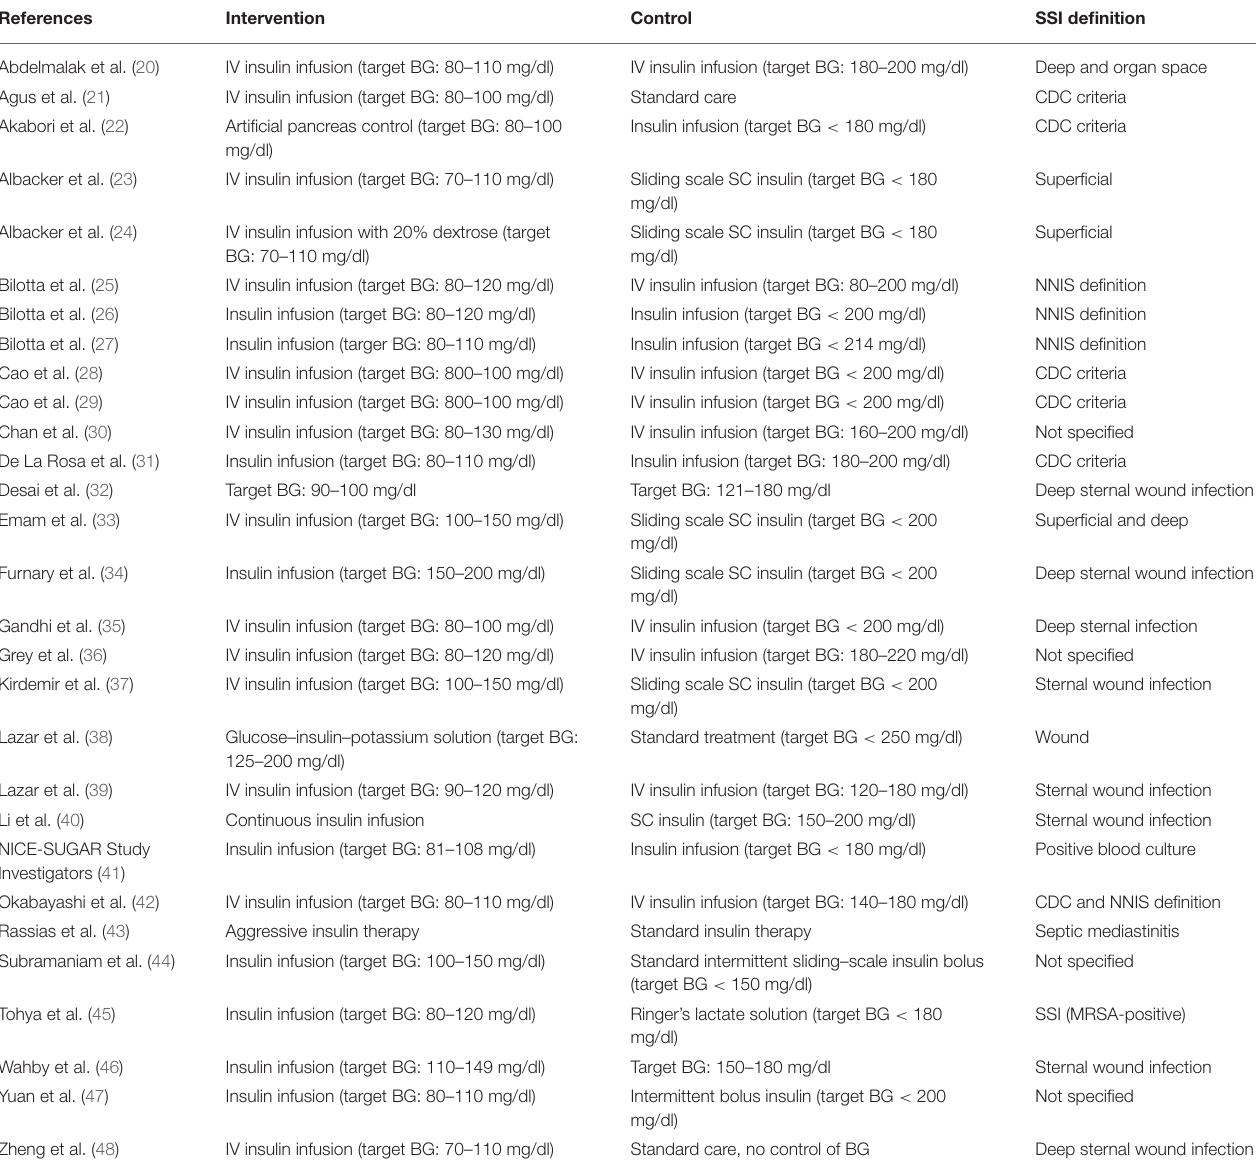
TABLE 2 | Study characteristics of the included